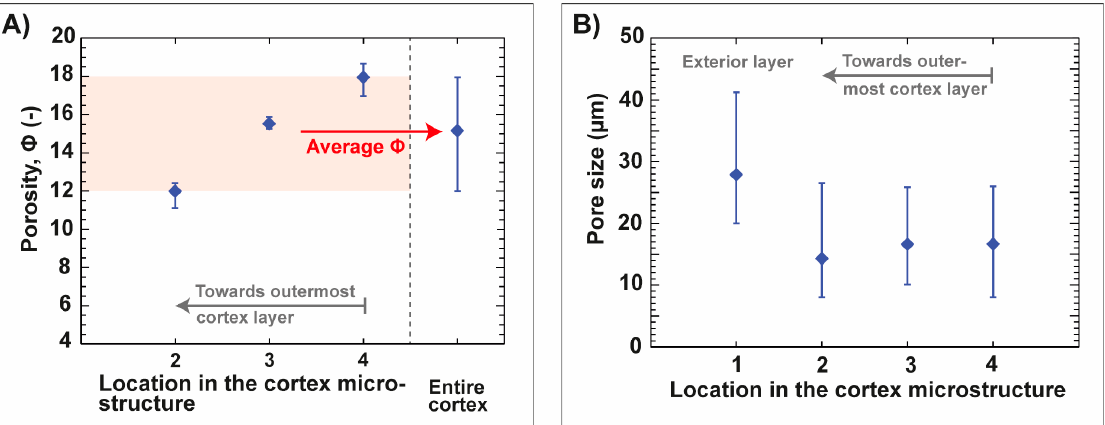
Figure 6. Porosity, Φ , of the cortex and the size of the pore channels within the cortex of the spine of Phyllacanthus imperialis . The porosity of the µCT sections of the cortex is displayed in ( A ). The average porosity of each µCT section is displayed in ( B ). The assignment of the µCT sections (2, 3, 4) is displayed in Figure 5B.